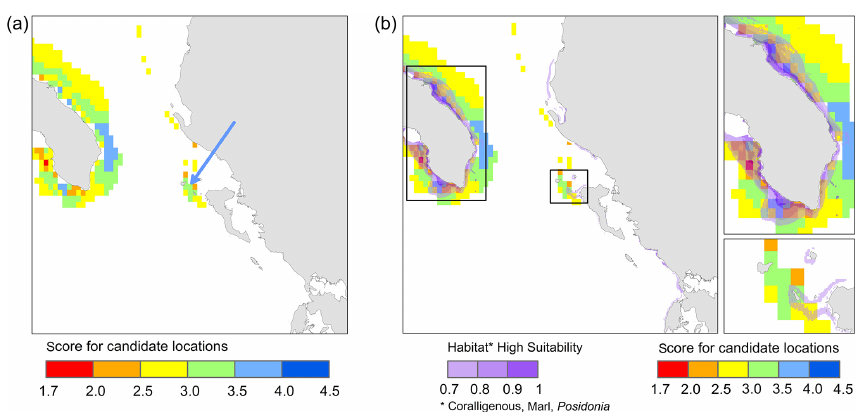
Figure 3. Overall score for candidate locations for OWF development in the Mediterranean pilot area (a) . Overall score combined with habitats (coralligenous formations, marls, Posidonia oceanica meadows) with high suitability in the Mediterranean pilot area (b)